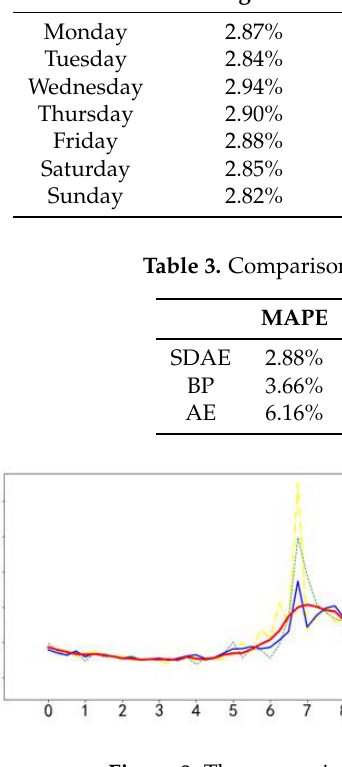
Figure 9. The comparisons of load forecasting results for a certain